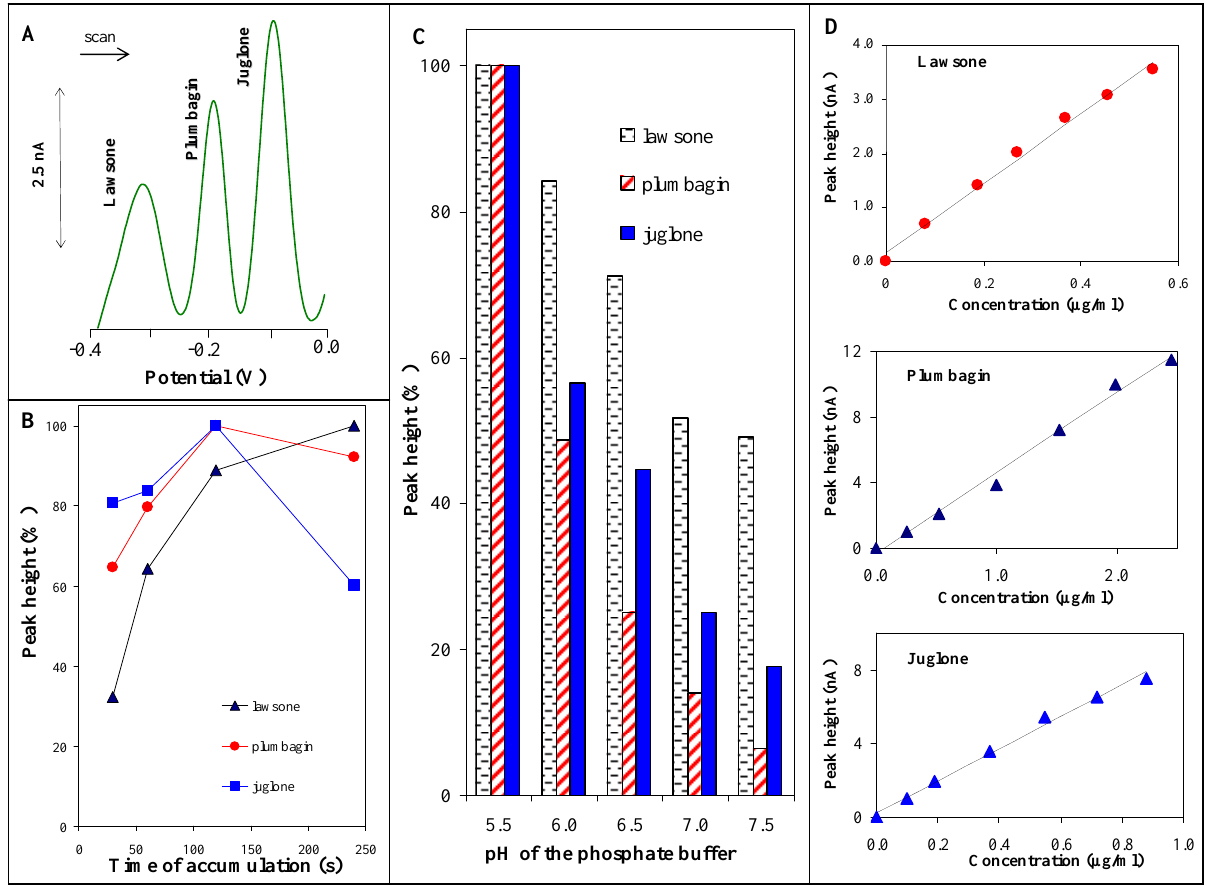
Figure 2. Naphthoquinone analysis by stationary electrochemical method. ( A ) The DP voltammogram of lawsone, juglone and plubagin (1 µg.ml -1 ) simultaneously determined on the surface of HMDE. The change of signal height of the naphthoquinones with increasing ( B ) time of accumulation and ( C ) pH of phosphate buffer – supporting electrolyte. Signal heights of 7 nA for lawsone, of 4 nA for plumbagin and of 8 nA for juglone correspond to the 100 %. ( D ) The dependence of naphthoquinone peak height on its concentration. The naphthoquinones were measured in the presence phosphate buffer (0.2 M) in potential range from –0.6 to 0 V with potential step 5 mV.s -1 and pulse amplitude 25 mV. For other details see “Materials and Methods”